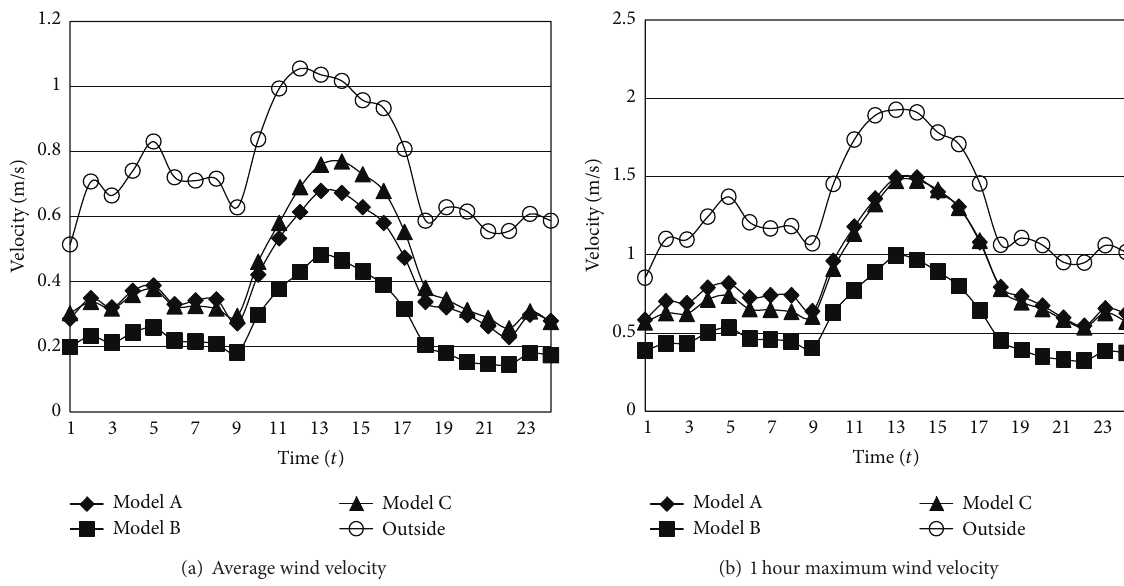
Figure 23: Average and maximum wind velocities during each